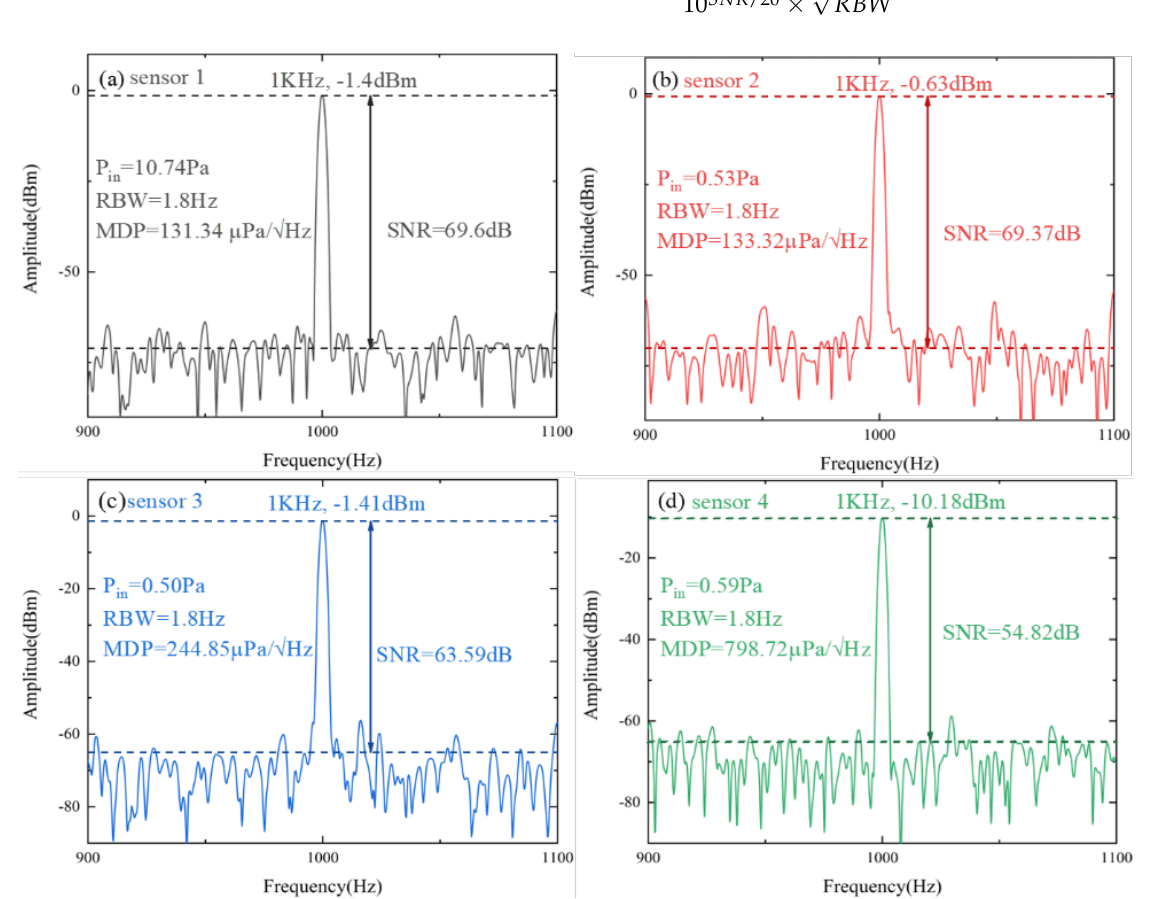
Figure 7. The MDP and SNR characteristics of the sensors at 1 kHz: ( a ) Q = 3.44 × 10 6 with the groove of 130 × 130 µm 2 ; ( b ) Q = 2.62 × 10 6 with the groove of 140 × 140 µm 2 ; ( c ) Q = 2.05 × 10 6 with the groove of 150 × 150 µm 2 ; ( d ) Q = 1.08 × 10 6 with the groove of 160 × 160 µm 2 .